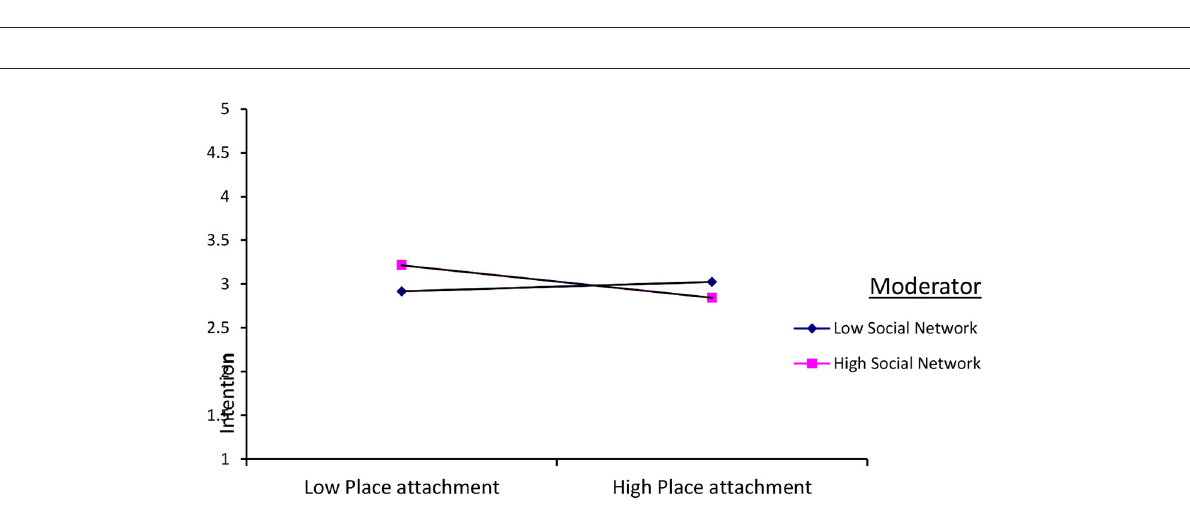
FIGURE3 The plot of the interaction effect of attitude and social networks on intention to migrate.